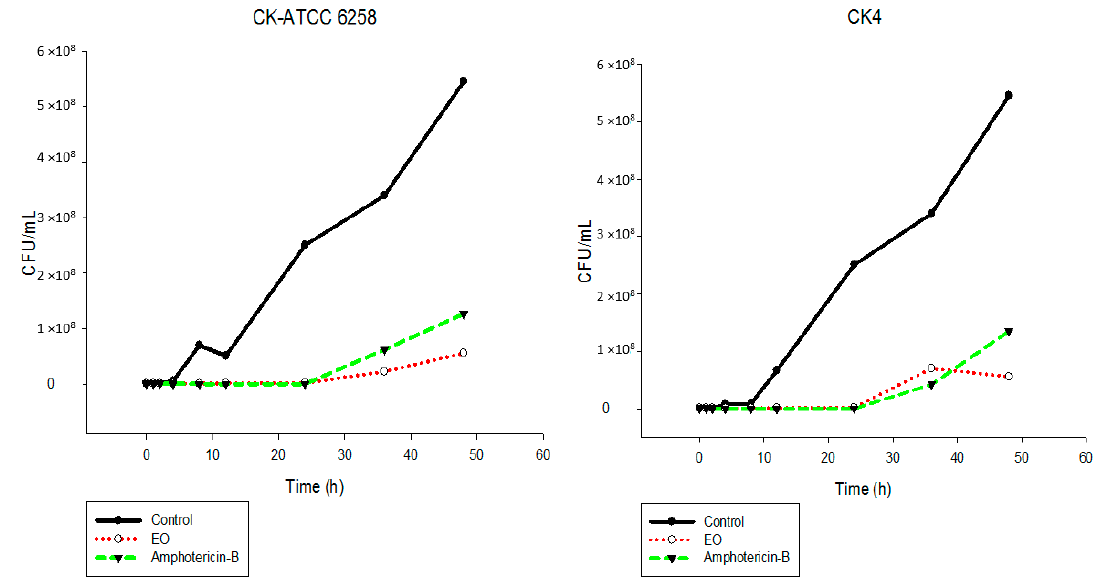
Figure 3. Time-kill curves of C. krusei ATCC 6258 and CK4 following exposure to the essential oil of C. nardus and amphotericin-B. Control represents the untreated Candida cells.